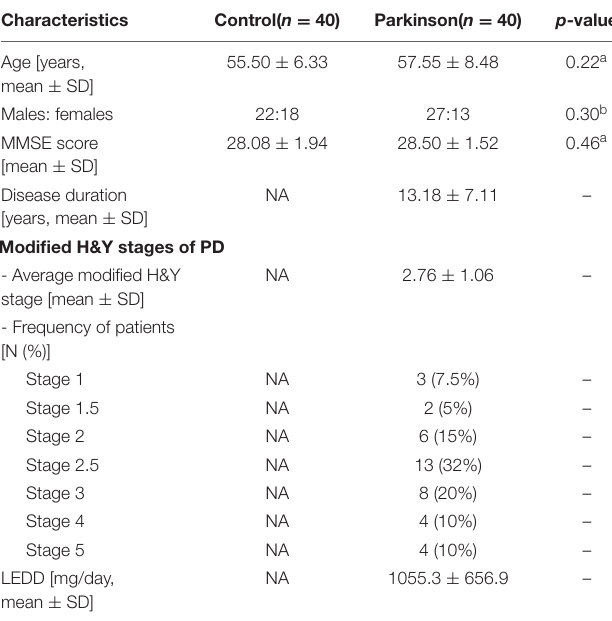
TABLE 1 | Demographic data and clinical characteristics of control and PD